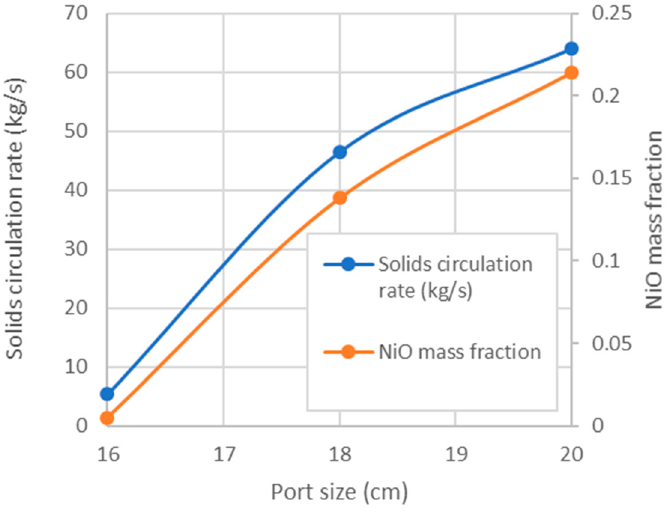
Figure 9. Plot of the solids circulation rate and the NiO mass fraction in the fuel section with changing port size.